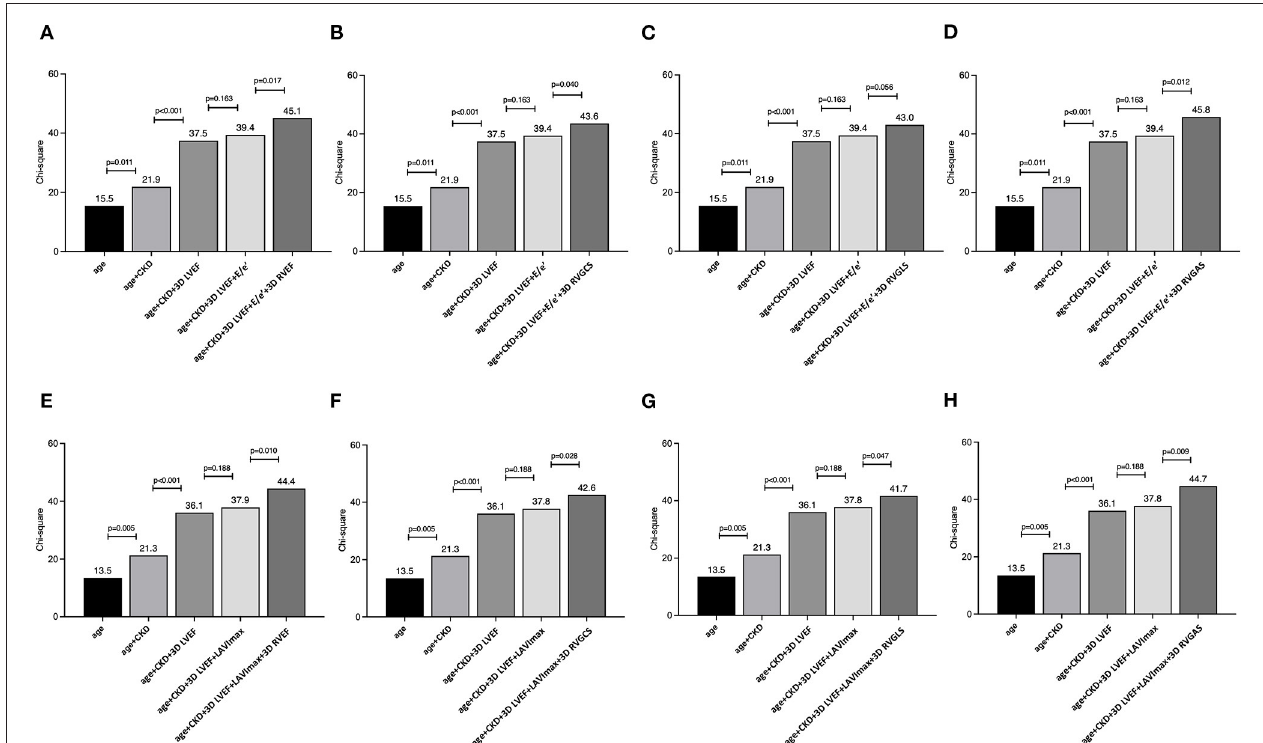
FIGURE 4 | The nested regression model to evaluate the incremental value of 3D RVEF, 3D RVGCS, 3D RVGLS, and 3D RVGAS for cardiac death, ventricular tachyarrhythmia, or HF hospitalization. χ 2 scores show that 3D RVEF, 3D RVGCS, and 3D RVGAS have significant incremental value for prediction of a composite of cardiac events in addition to models, including age, chronic kidney disease, left ventricular ejection fraction, and average mitral E/e’ (A–D) . χ 2 scores show that 3D RVEF, all 3D global strains have significant incremental value for prediction over the models, including age, chronic kidney disease, left ventricular ejection fraction, and maximum 3D left atrial volume index (E–H)